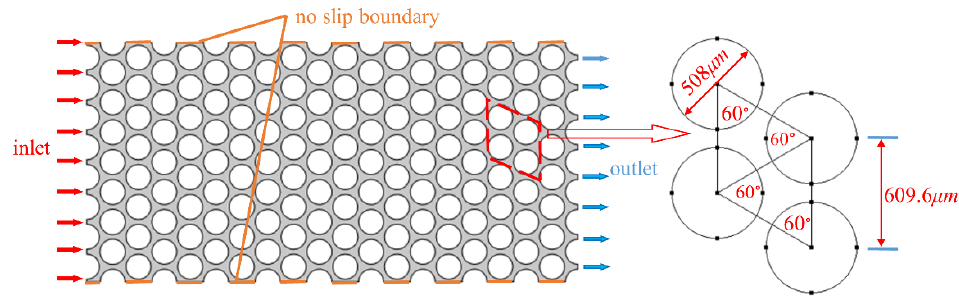
The left side of the model is the velocity inlet, and CO 2 is injected from the left side, with an injection velocity of 0.01 m/s; the right side is the pressure outlet, the outlet pressure is 0 Pa, and the grain surface and the upper and lower boundaries of the model are defined as non-slip boundaries.